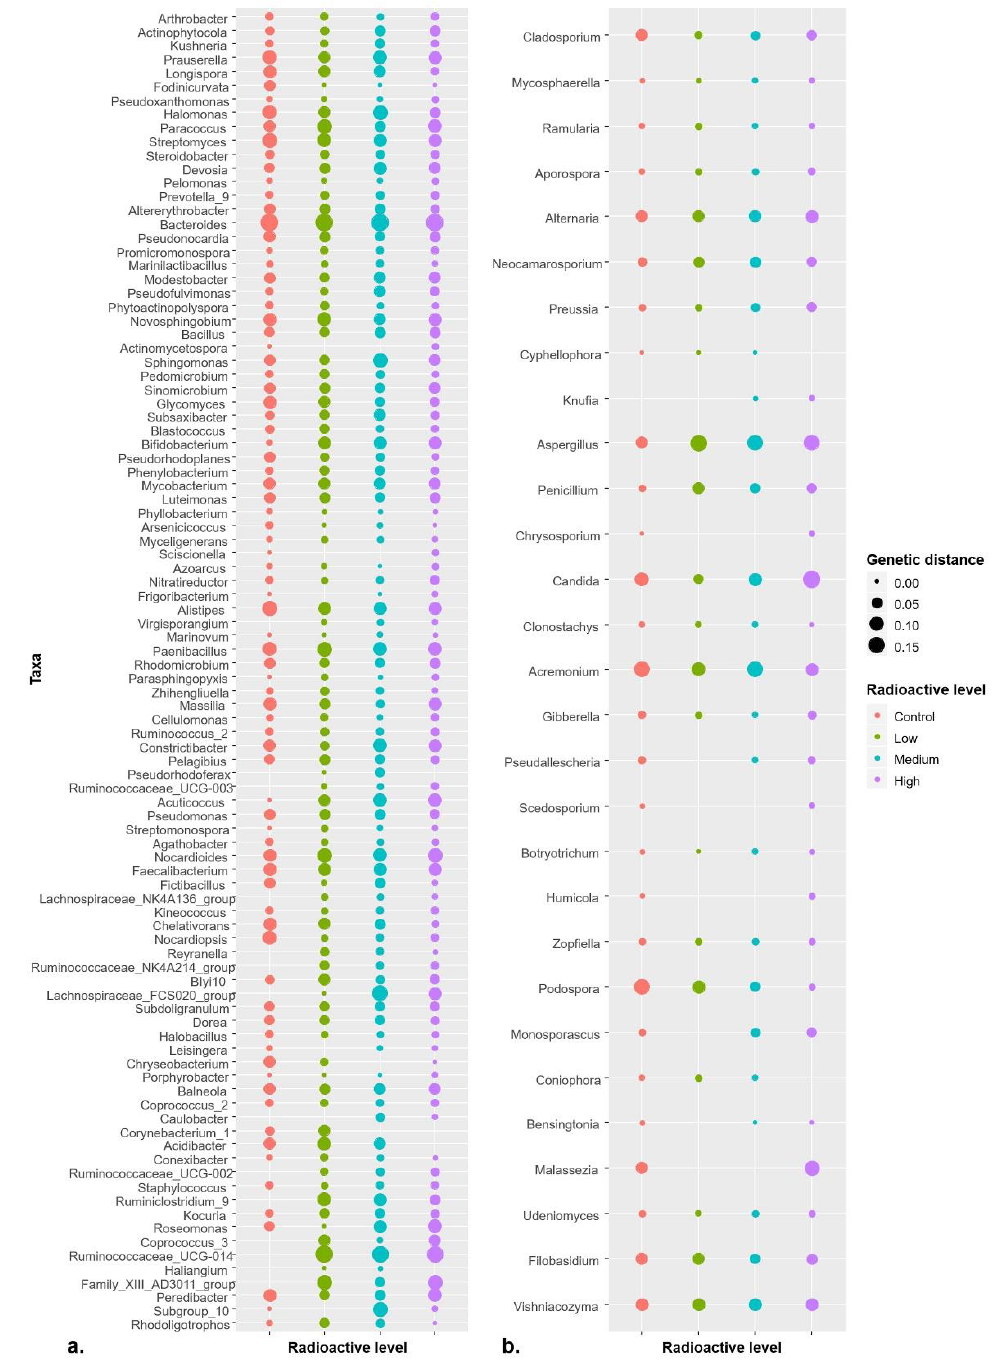
Figure 5. The shifting average genetic distances of bacterial ( a ) and fungal ( b ) genera among treatments of different radiation levels. Taxa shown in figure were those with significant difference in genetic distances among radiation levels tested with ANOVA. For entire list of bacterial and fungal genera with detailed values, please see Tables S2 and S3, respectively.